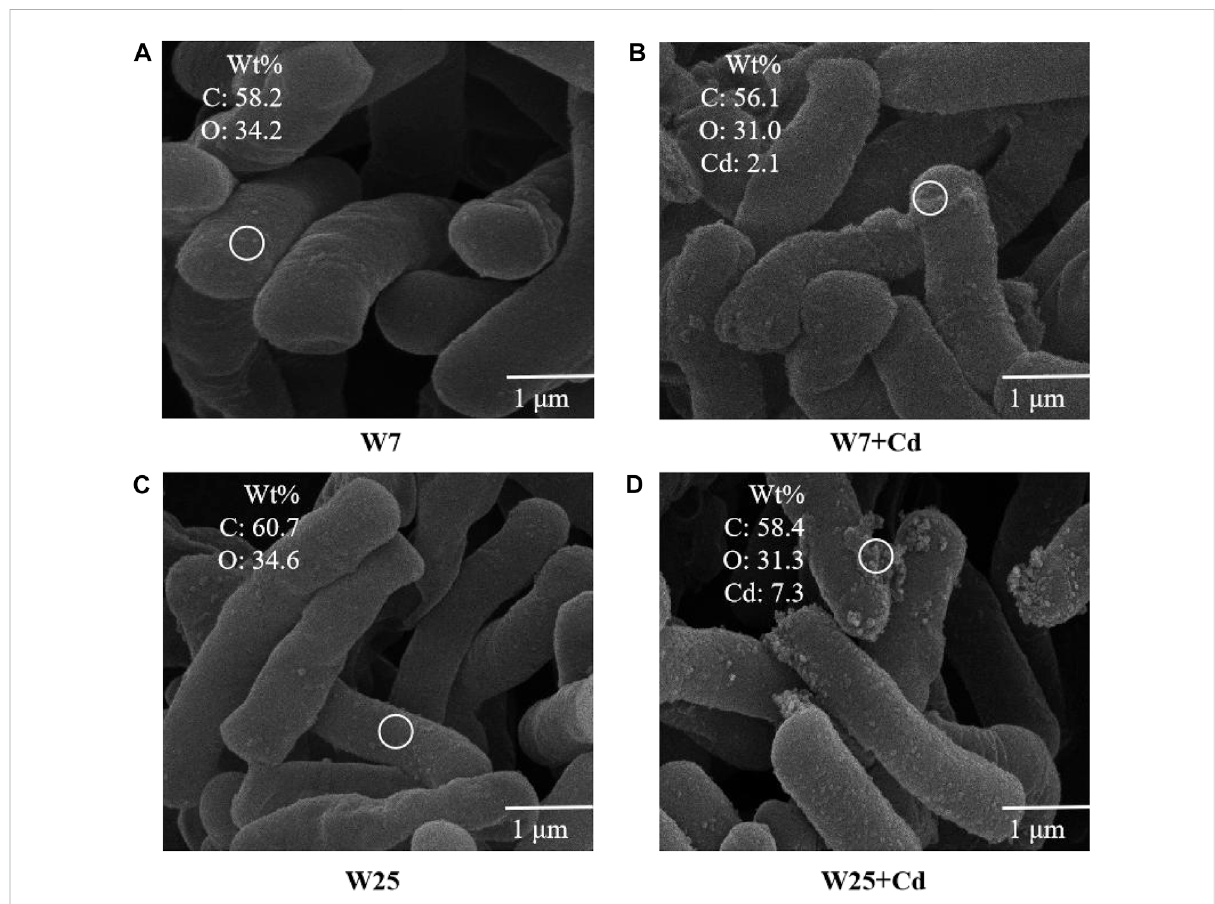
FIGURE 2 SEM-EDS images of strains W7 and W25 with or without Cd. (A) SEM-EDS image of strain W7 in the absenceof Cd; (B) SEM-EDS imageof strain W7 in the presence of 20 mg L − 1 Cd; (C) SEM-EDS image of strain W25 in the absence of Cd; (D) SEM-EDS image of strain W25 in the presence of 20 mg L − 1 Cd. The white circles indicate selected spots for